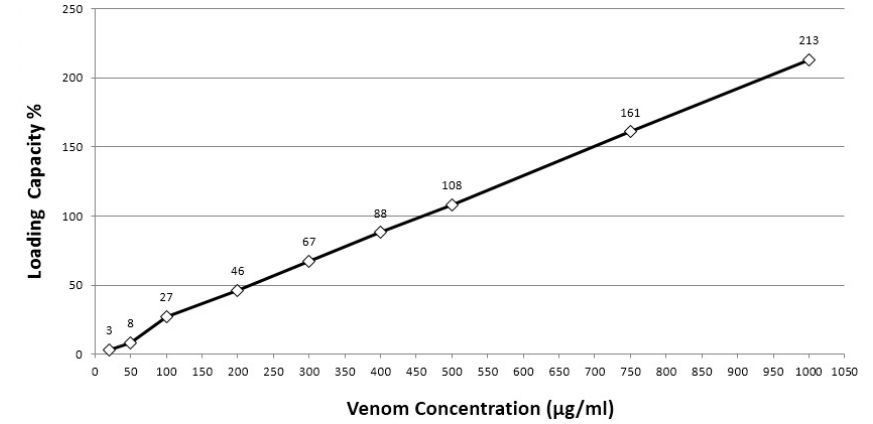
Fig. 4. The influence of Vipera albicornuta venom initial concentration on LC (CS: 2.5 mg/mL, TPP: 1